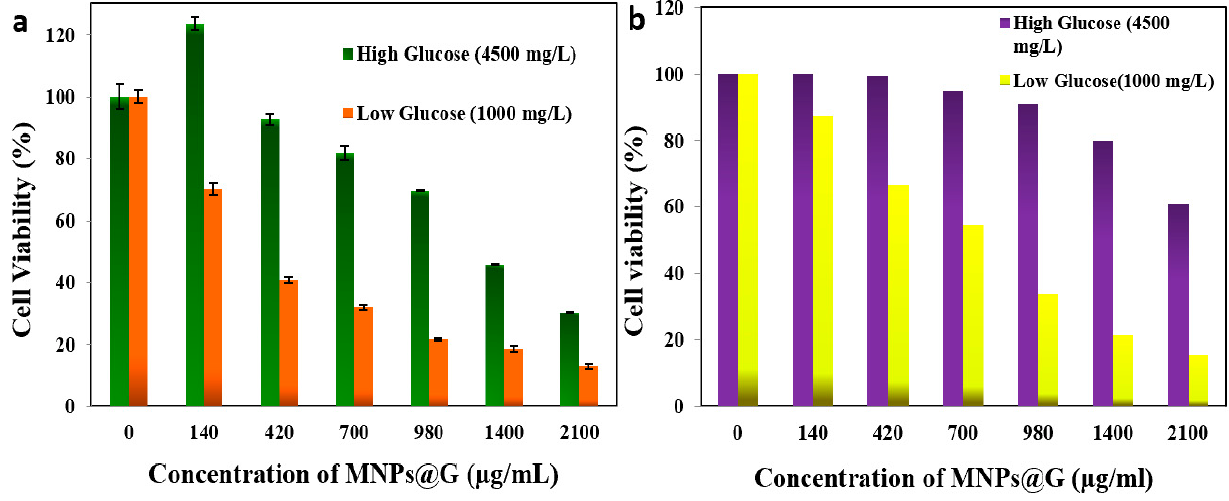
Figure 4. ( a ) A375 melanoma and ( b ) HeLa cell viability according to CCK-8 assay as a function of mNP@G concentration after 62 h incubation in high glucose growth medium (4500 mg·L − 1 ) and 15 h incubation in low glucose growth medium (1000 mg·L − 1 ).